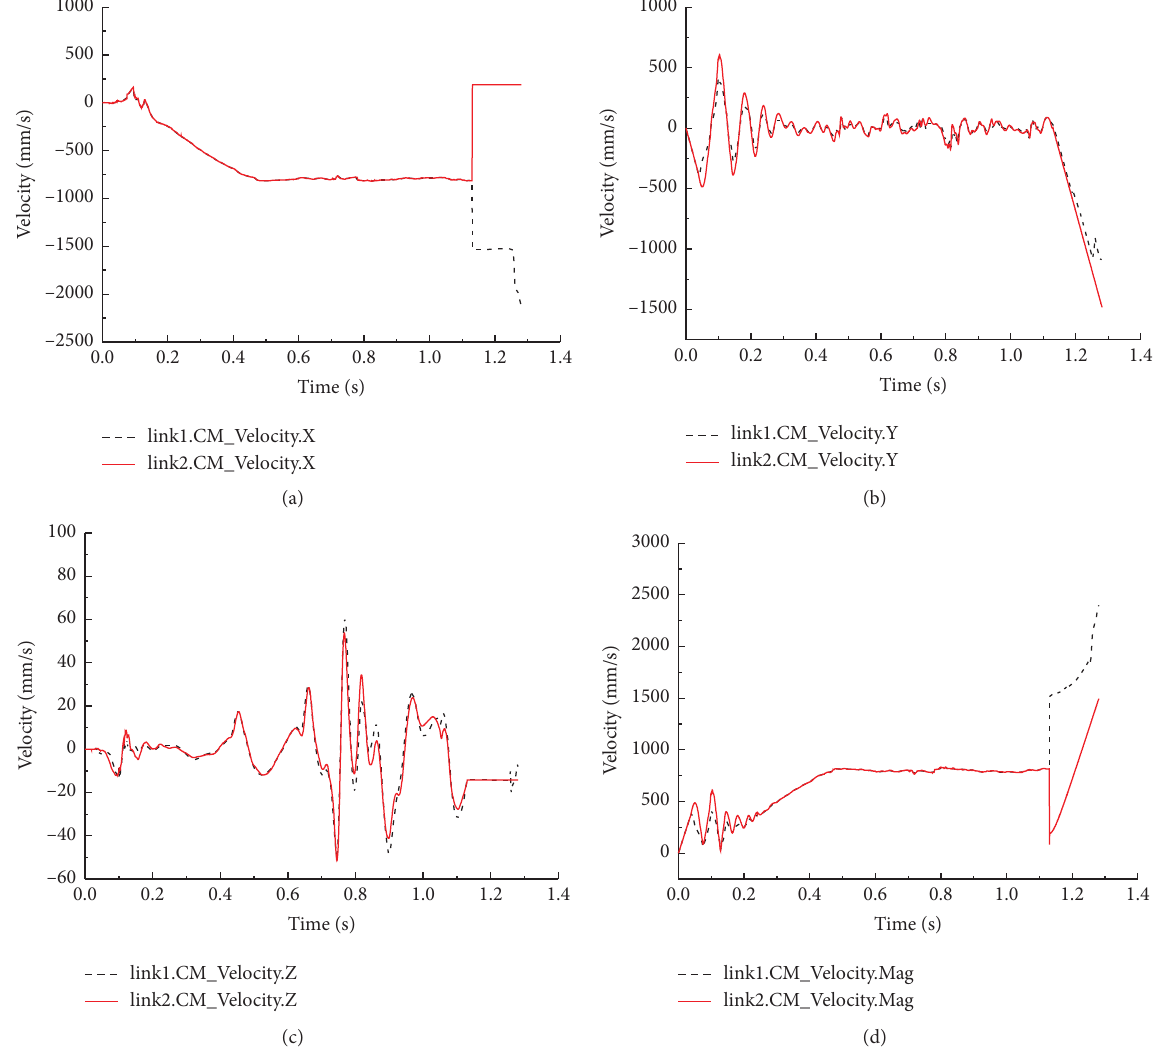
Figure 17: Link velocity change curve at the chain rupture position. (a) Velocity in the X direction. (b) Velocity in the Y direction. (c) Velocity in the Z direction. (d) Velocity